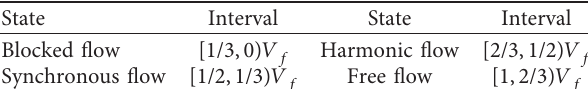
Table 1: Traffic state classification